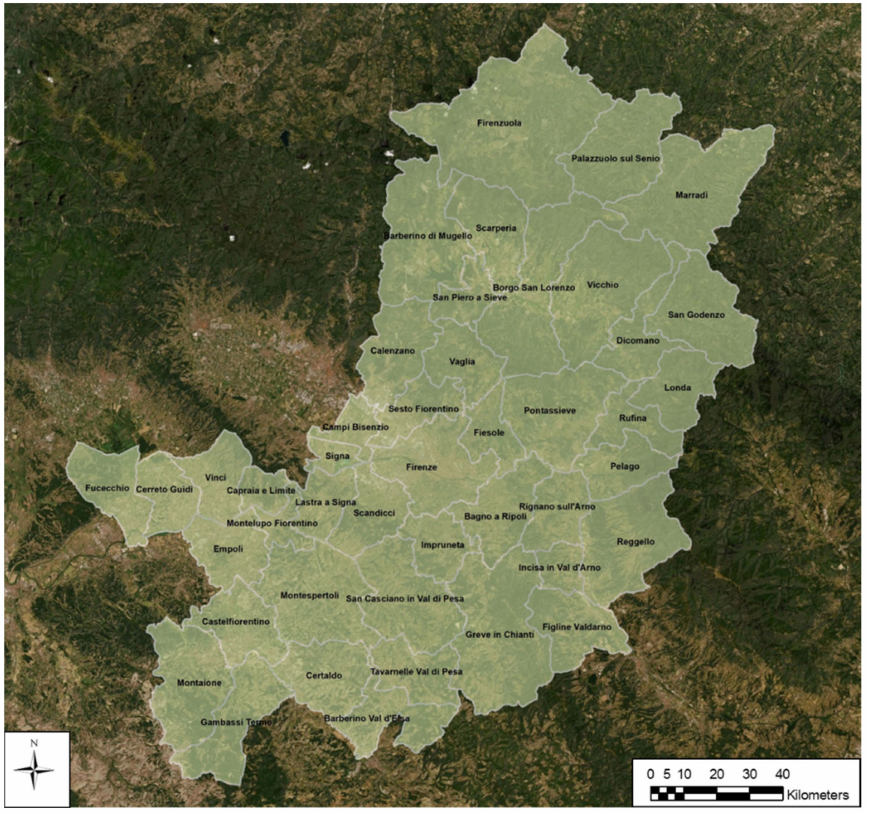
Figure 6. The study area: the municipalities of the province of Florence (Italy).